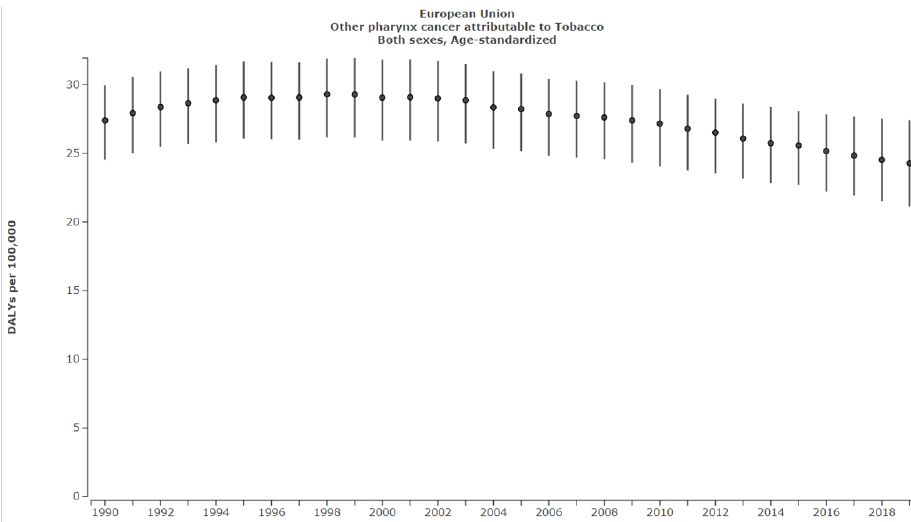
Figure 7. Other pharyngeal cancer in Ireland attributable to tobacco. Source: Institute for Health Metrics Evaluation. Used with permission. All rights reserved [1].